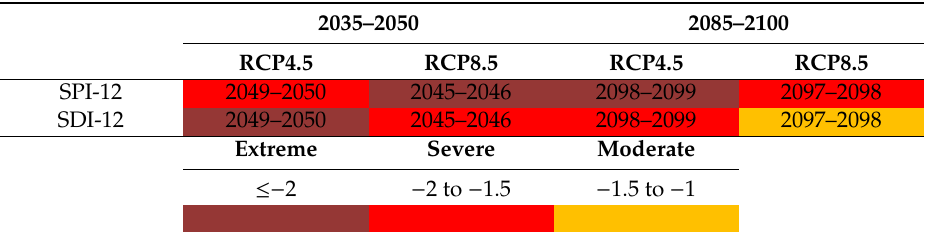
Table 5. The selected dry years for spatial drought